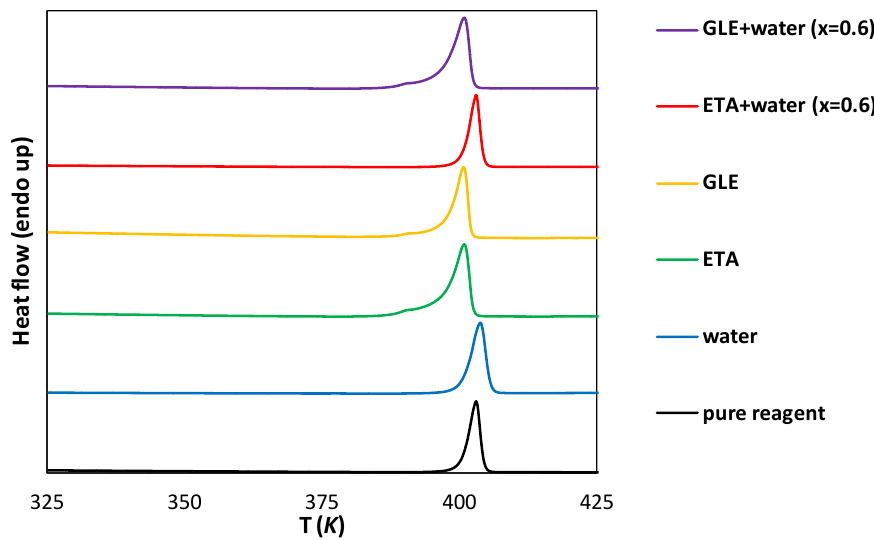
Figure 4. DSC curves of edaravone precipitates after solubility measurements in neat DES, water and their mixtures (optimal composition). Values in parentheses indicate the mole fractions of DES in solute-free solutions. The DSC curve of pure edaravone is also provided for comparison.